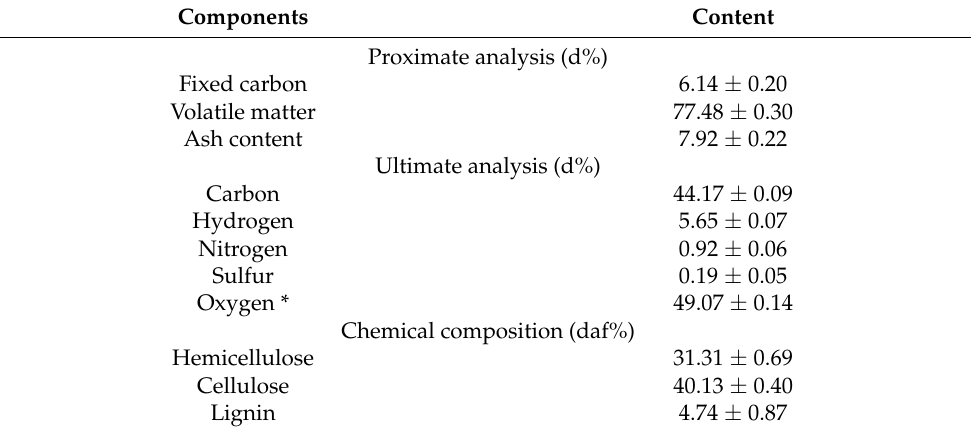
Table 1. Characteristics of corn